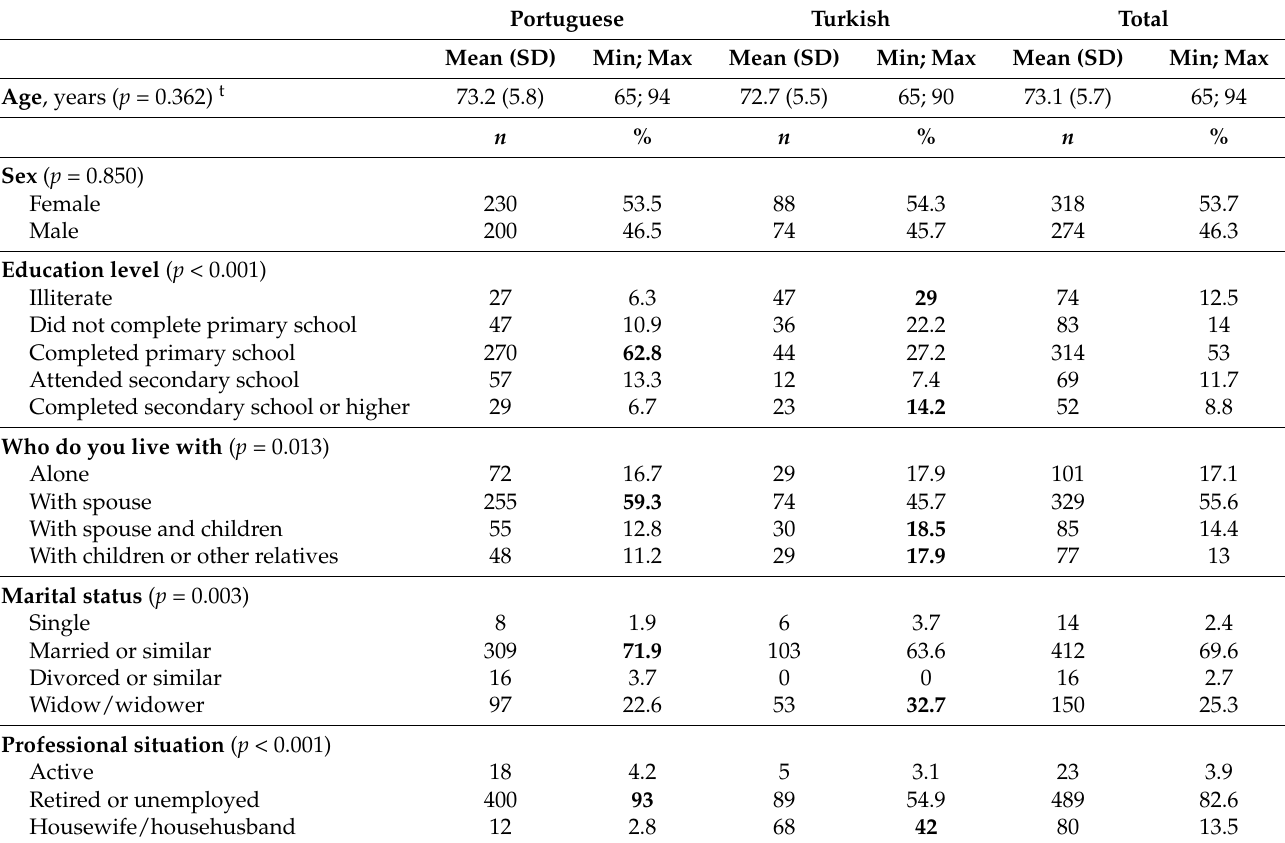
Table 1. Comparisons between countries regarding sociodemographic